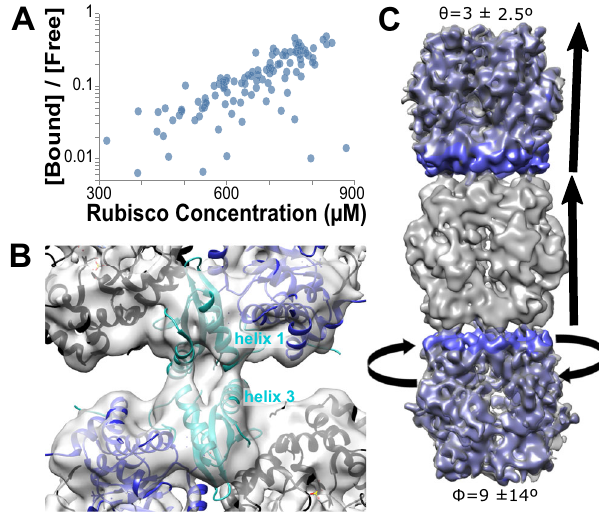
Fig. 4 | Rubisco polymerizes to form fi brils. A Rubisco-Rubisco binding scales with concentration. B A 10Å slab through the subtomogram average of the Rubisco-Rubisco interface with the docked 1SVD crystal structure shows an inter- action between helices 1 and 3 of the small subunit (cyan; large subunit, blue; additional subunits, black). C A subtomogram average of Rubisco fi brils (gray) showsvariable tilt( θ )and twist ( ϕ ) in the interaction.Adifferencemapofthe fi bril and freeRubiscos shows densityonly in the Rubiscos above and below(blue),with no other protein mediating the